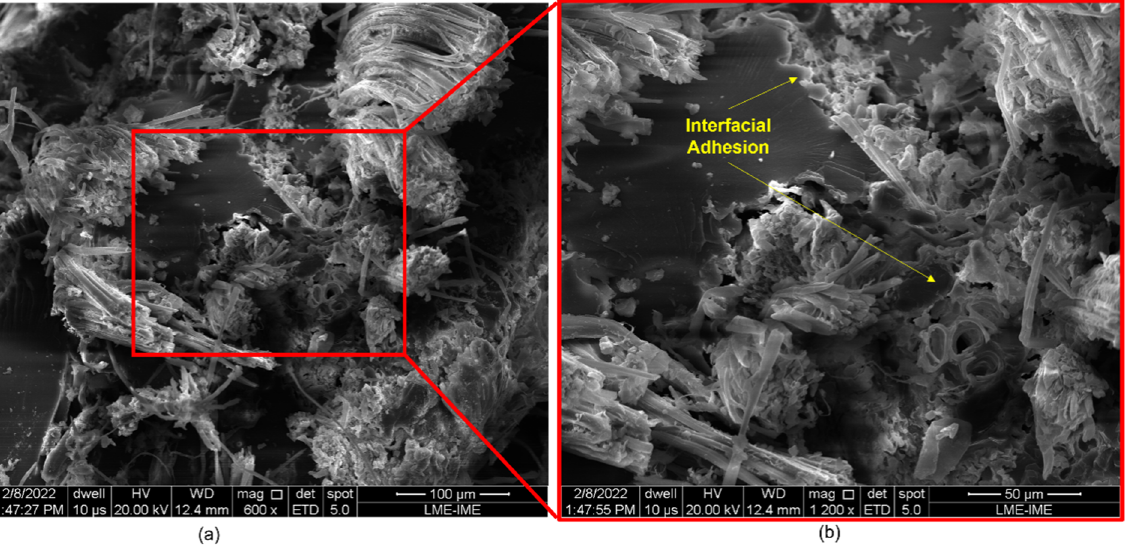
Figure 8. Fracture surface of a composite with 20 vol.% of fibers (PGO/ENT) arranged: unidirection- ally ( a ) and bidirectionally ( b ), at 200× magnification.